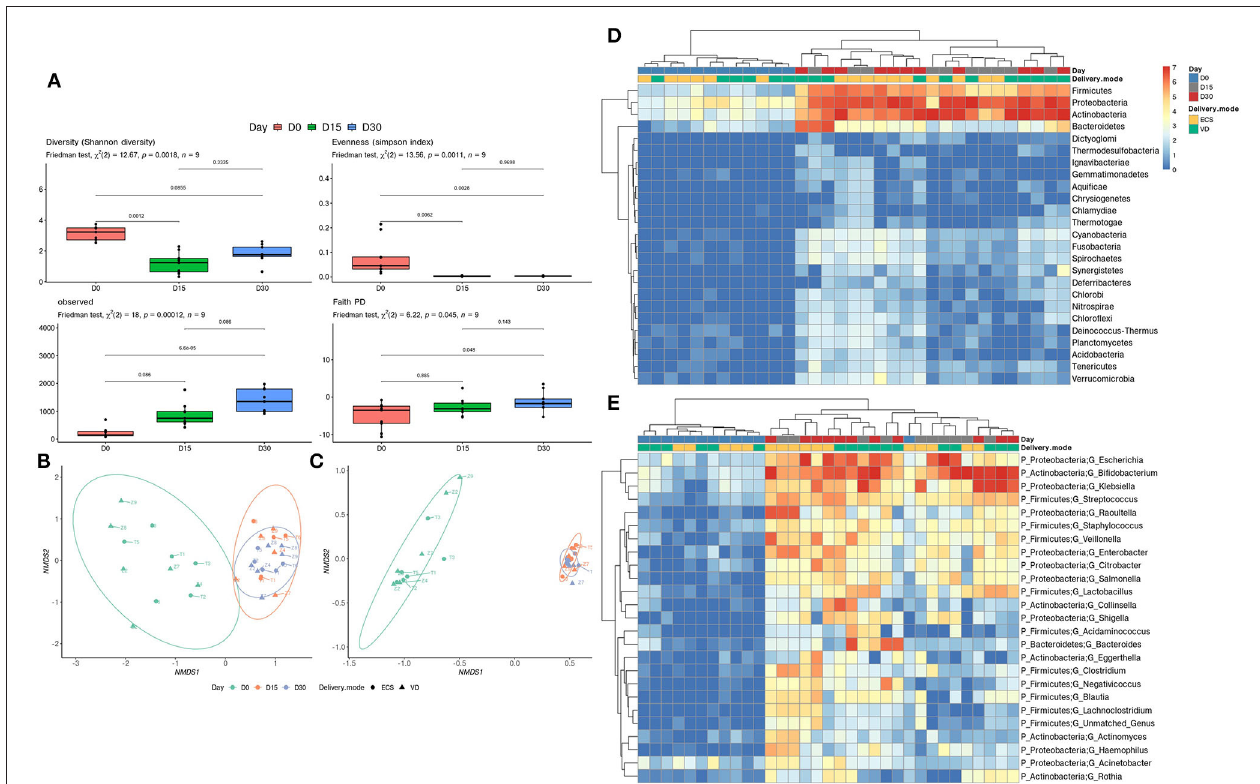
FIGURE 1 | Development of early gut microbiota of Tunisian newborns. (A) Alpha diversity was measured by estimating the Shannon index (top right panel), Simpson index (top left panel), observed OTU richness (bottom left panel), and Faith phylogenetic diversity (bottom right panel). Significant differences between groups were determined using the Friedman test followed by a Nemenyi post-hoc test. Ordination plot with nonmetric multidimensional scaling (NMDS) based on the relative abundance of taxa (B) and pathways (C) in newborns’ gut microbiota. Heatmap of relative abundance (log 10 transformed) of the 25 most abundant taxa at the phylum (D) and genus level (E) . The clustering was performed based on Bray–Curtis distance